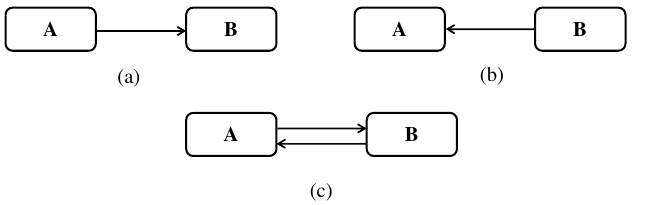
Figure 24. ( a ) An acyclic model M1, ( b ) an acyclic model M2, and ( c ) a union model of M1 and M2 that is cyclic. Note: these three models satisfy Φ p , as they have no